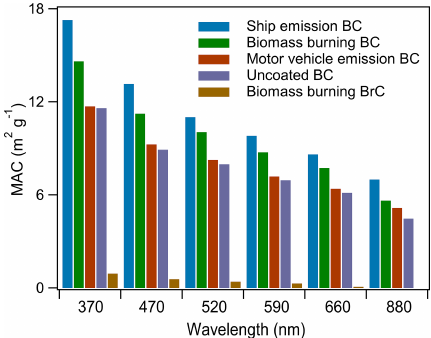
Figure 6. The source-specific mass absorption cross section (MAC) of black carbon (BC) and brown carbon (BrC) at different wave- lengths. The MACs of uncoated BC particles at each wavelength are extrapolated from 7.5m 2 g − 1 at 550nm (Bond and Bergstrom, 2006) by assuming an BC absorption Ångström exponent of